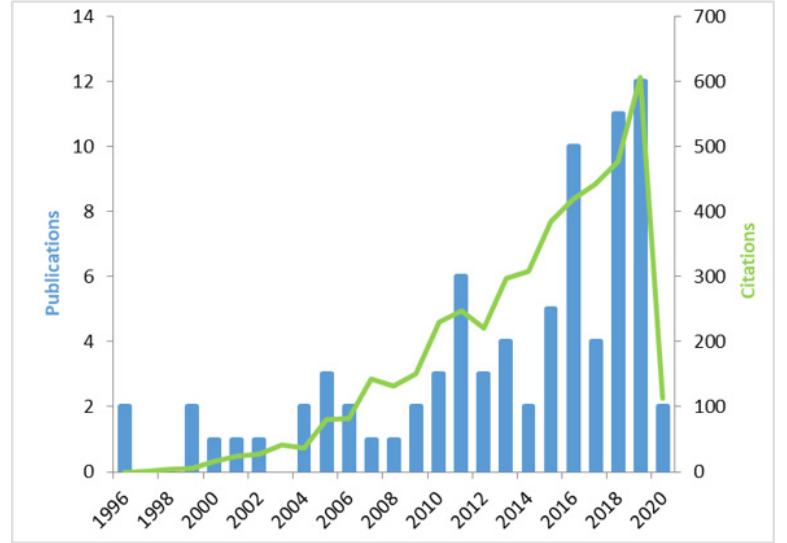
Figure 2. Total publications and citations by year. Table 2. Top ten most-cited